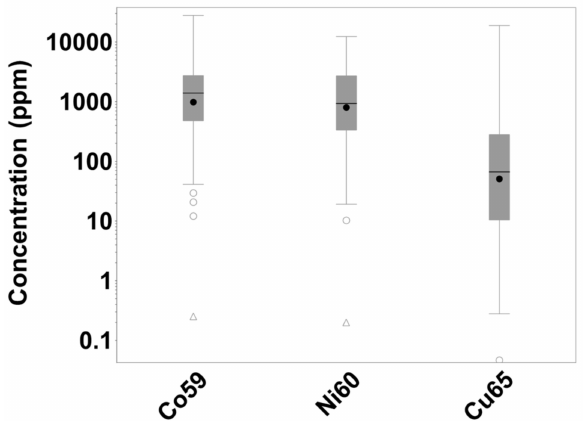
Figure 7. Box and whisker plot ( n = 143) showing cobalt, nickel and copper concentration in pyrite from the rougher concentrate (NB. the box covers the interquartile range, the line is the median and the circle the mean. The whiskers are drawn at the threshold to identify near and far outliers based on the Tukey statistic).